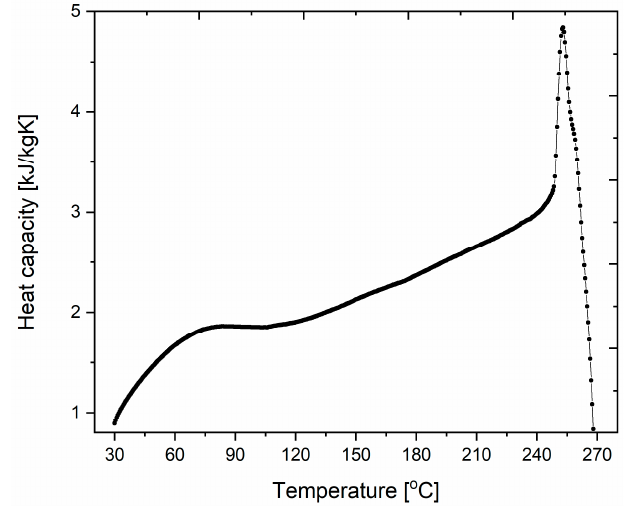
Figure 6. The differential scanning calorimetry (DSC) results of the aerogel sample.